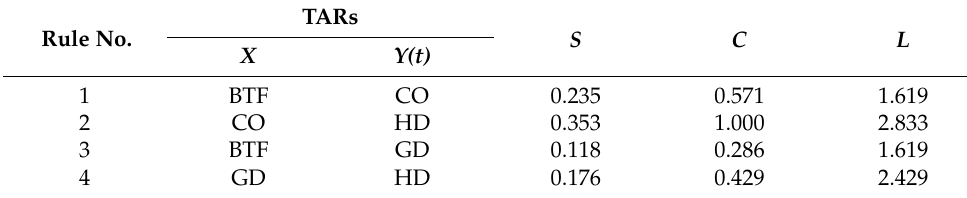
Table 10. TAR results for passenger ships.